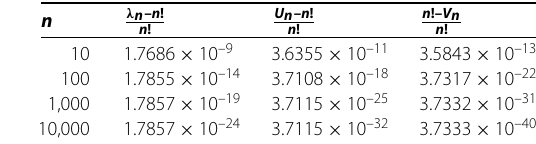
Table 1 Comparison among approximation formulas